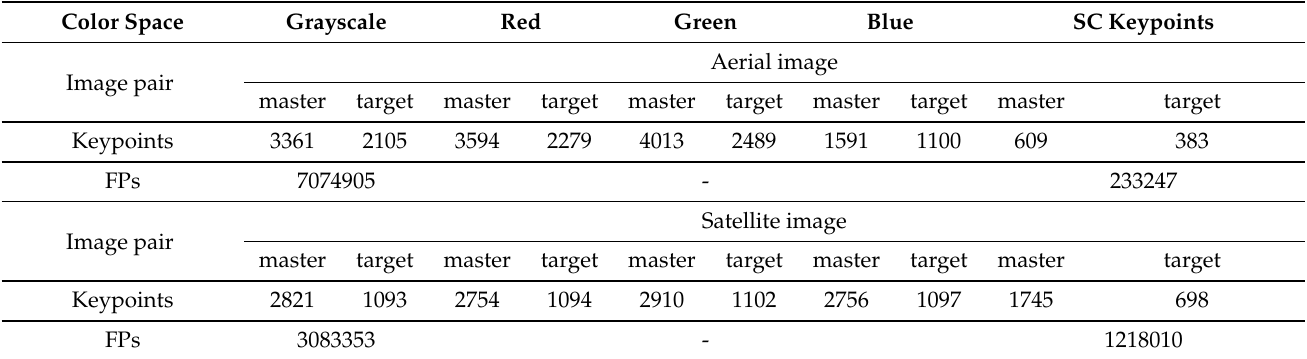
Table 5. Number of keypoints detected and feature pairs (FPs) of each benchmark image pair in the four color spaces using aerial and satellite images.